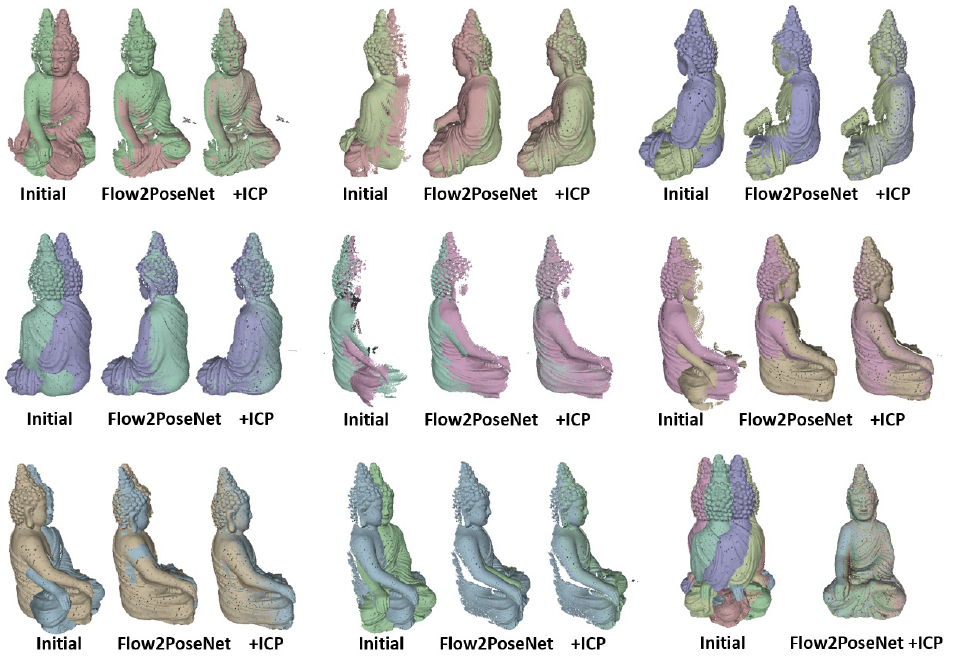
Figure 12. Application of the method to a full sequence of partial reconstructions of a real Buddha object from the BuddhaBirdReal dataset. Such sequences usually result from 3D scanners (as here from a structured light scanner). Since often a turntable is used, strong rotations ( ≈ 45 ◦ ) and shading changes disturb the data. After pre-alignment, a few iterations of the ICP algorithm are applied to refine the alignment of the point clouds. The image on the bottom right shows the impressive result on the overall aligned full point cloud of the